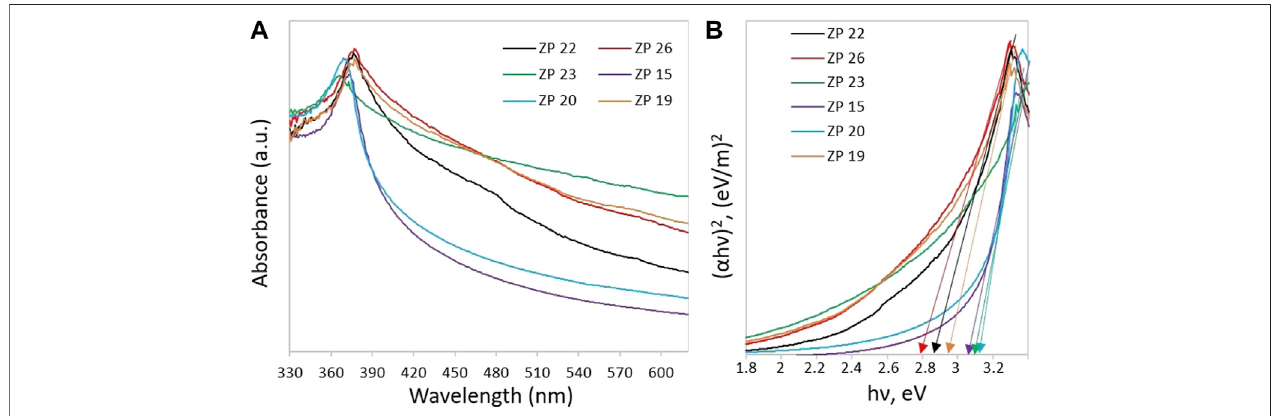
FIGURE 4 | (A) UV – Visible spectra and (B) Tauc ’ s plot for the determination of the ZnO samples band gap.